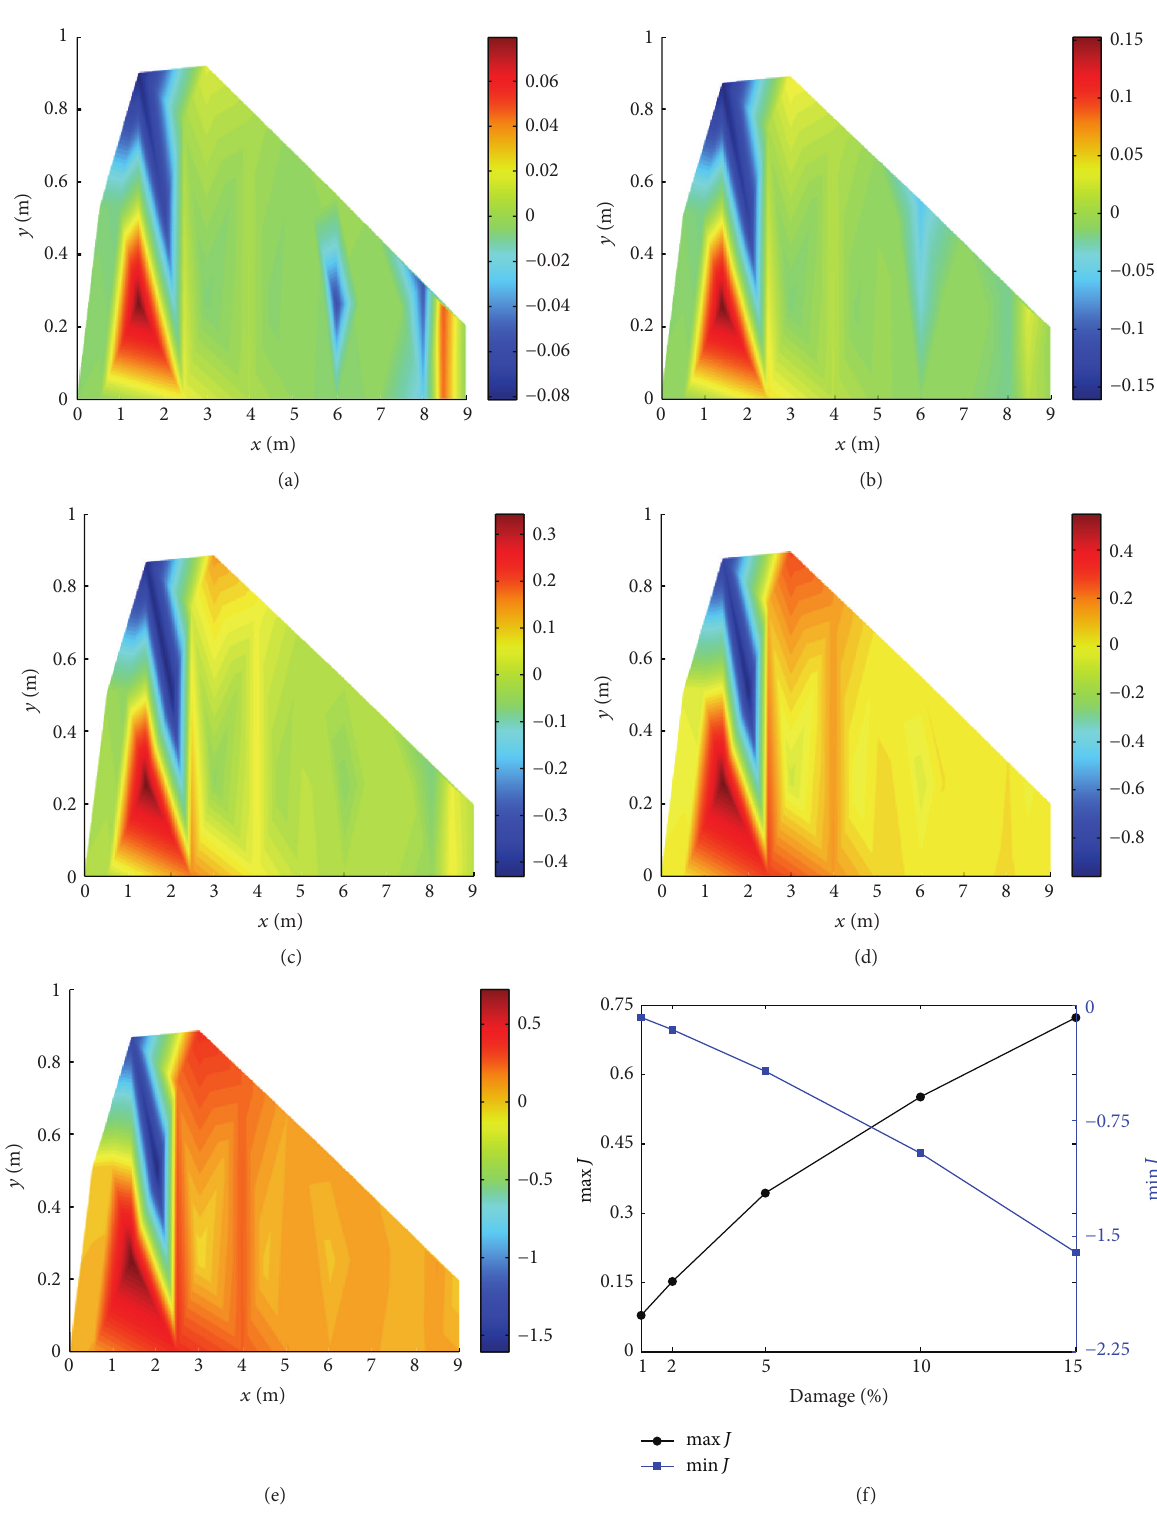
Figure 11: Damage maps 𝐽 for damage cases when considering the sparse sensor network of Figure 10. Damage corresponds to (a) 1%, (b) 2%, (c) 5%, (d) 10%, and (e) 15% reduction in the first natural frequency of the